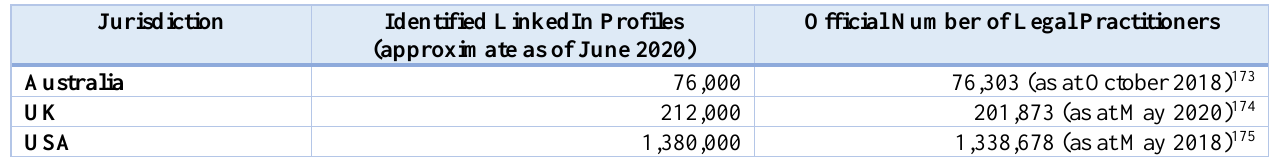
Table 1: The Population of Legal Practitioners on LinkedIn